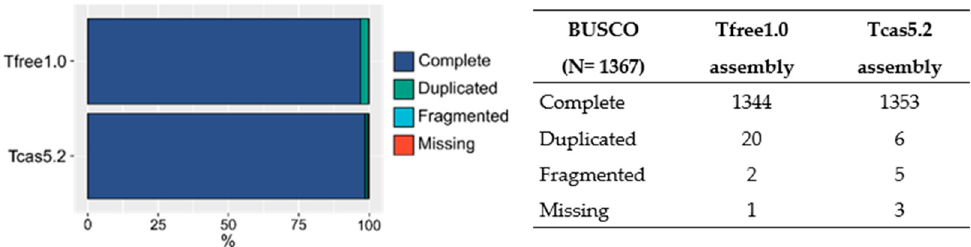
Figure 3. Gene completeness assessment using BUSCO analysis of T. freemani Tfree1.0 and T. castaneum Tcas5.2 assembly on all linkage groups and unplaced contigs in both species. Comparison of complete and single-copy, complete and duplicated, fragmented and missing BUSCO genes expressed in percentages ( left ) and absolute gene numbers ( right